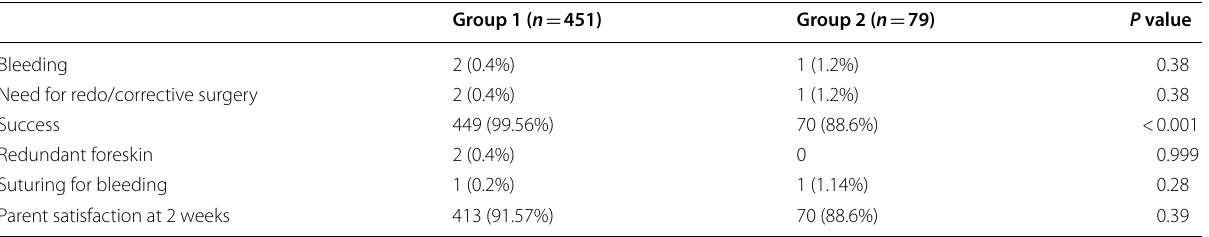
Table 2 Comparison of the post-circumcision data between neonates with normal penile anatomy and webbed penis